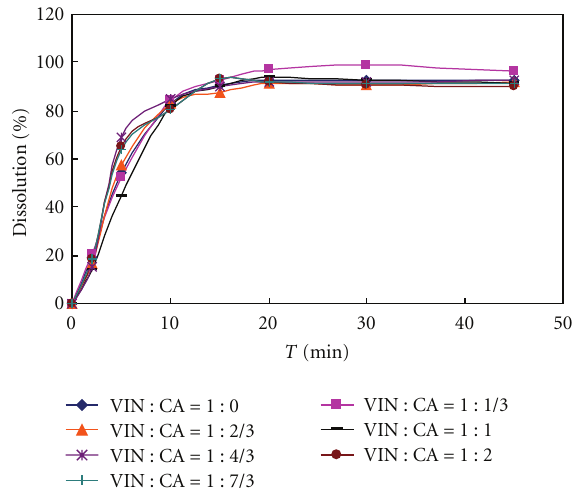
Figure 5: Influence of molar ratio of citric acid and vinpocetine on drug release profile (coating tablets in 0.5% SDS); VIN: vinpocetine; CA: citric